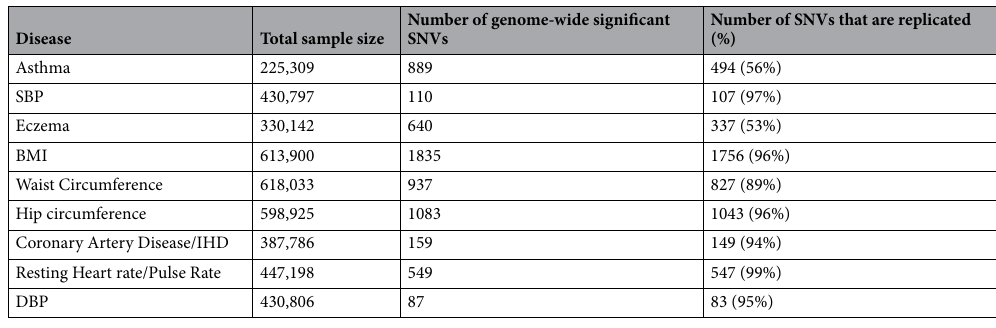
Table 1. Replication across phenotypes. Total sample size is the sample size of the discovery and replication GWAS collectively.